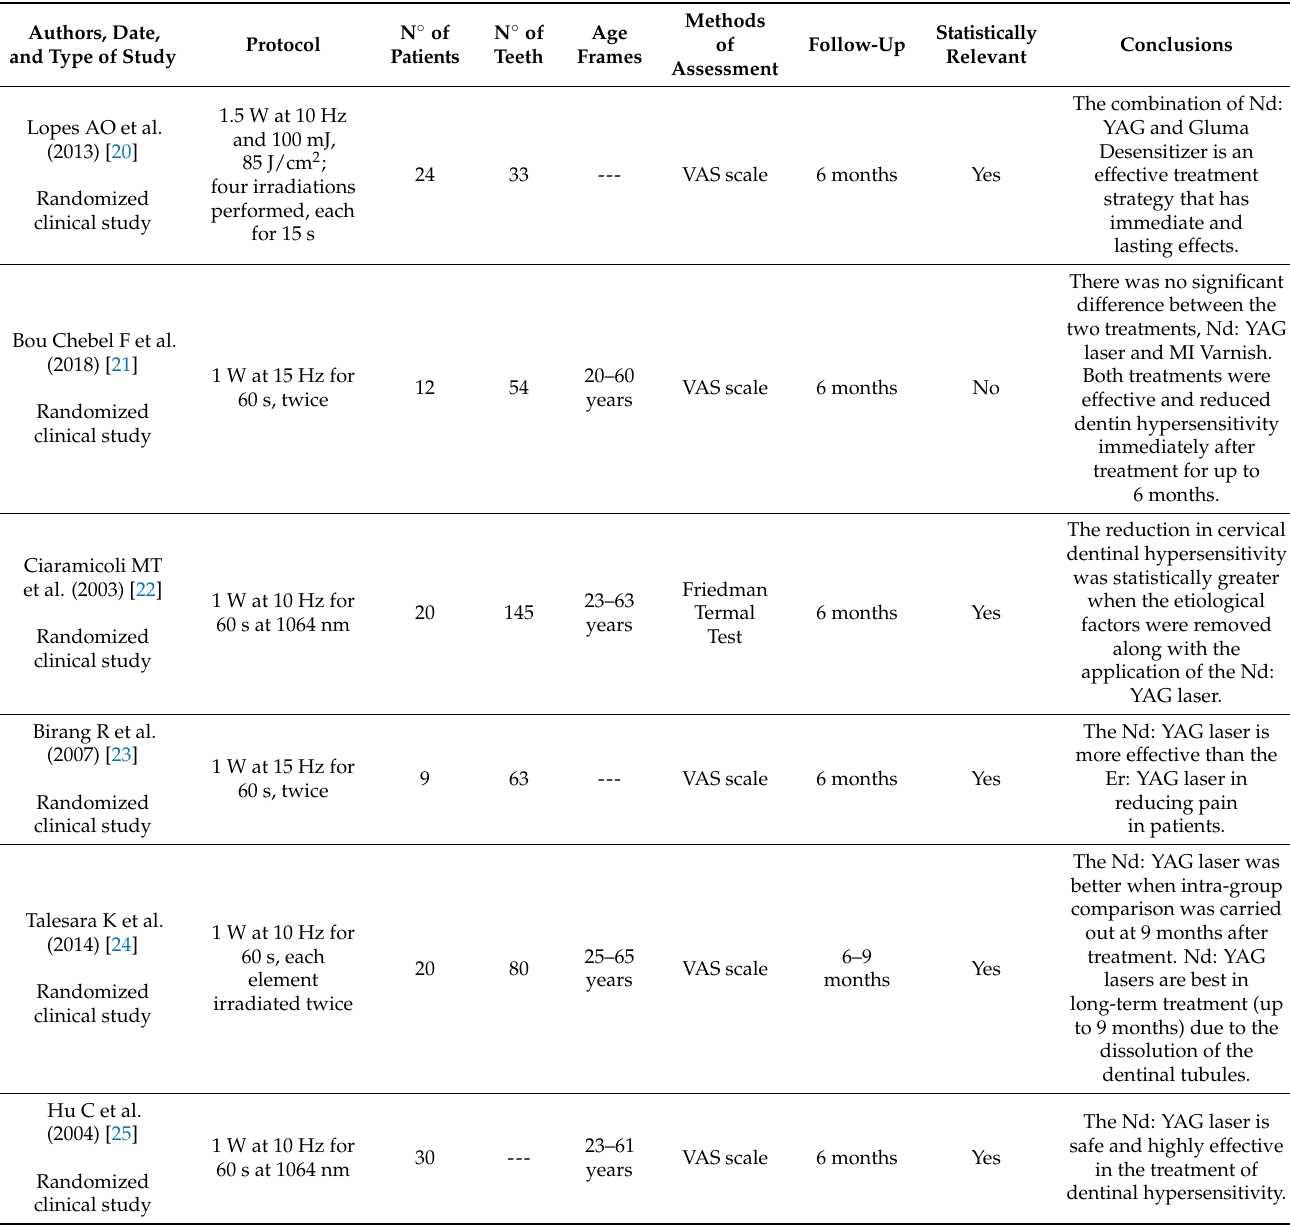
Table 1. Characteristics of the included studies on the use of the Nd: YAG laser in dentinal hypersensitivity